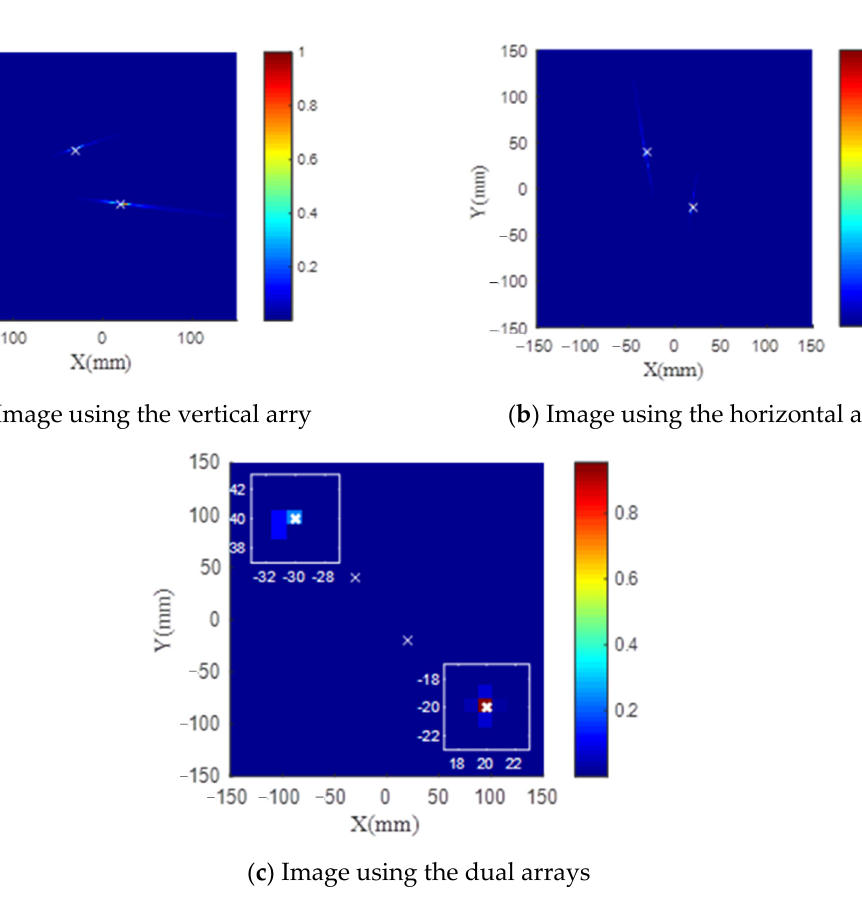
Figure 14. Simulation model containing dual arrays.